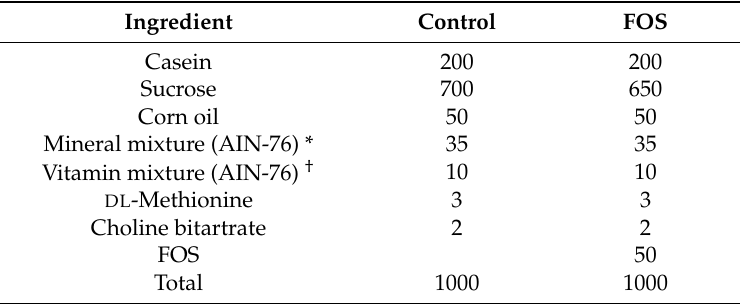
Table 1. The composition of control and fructooligosaccharides (FOS) diets (g/kg). Ingredient Control FOS Casein